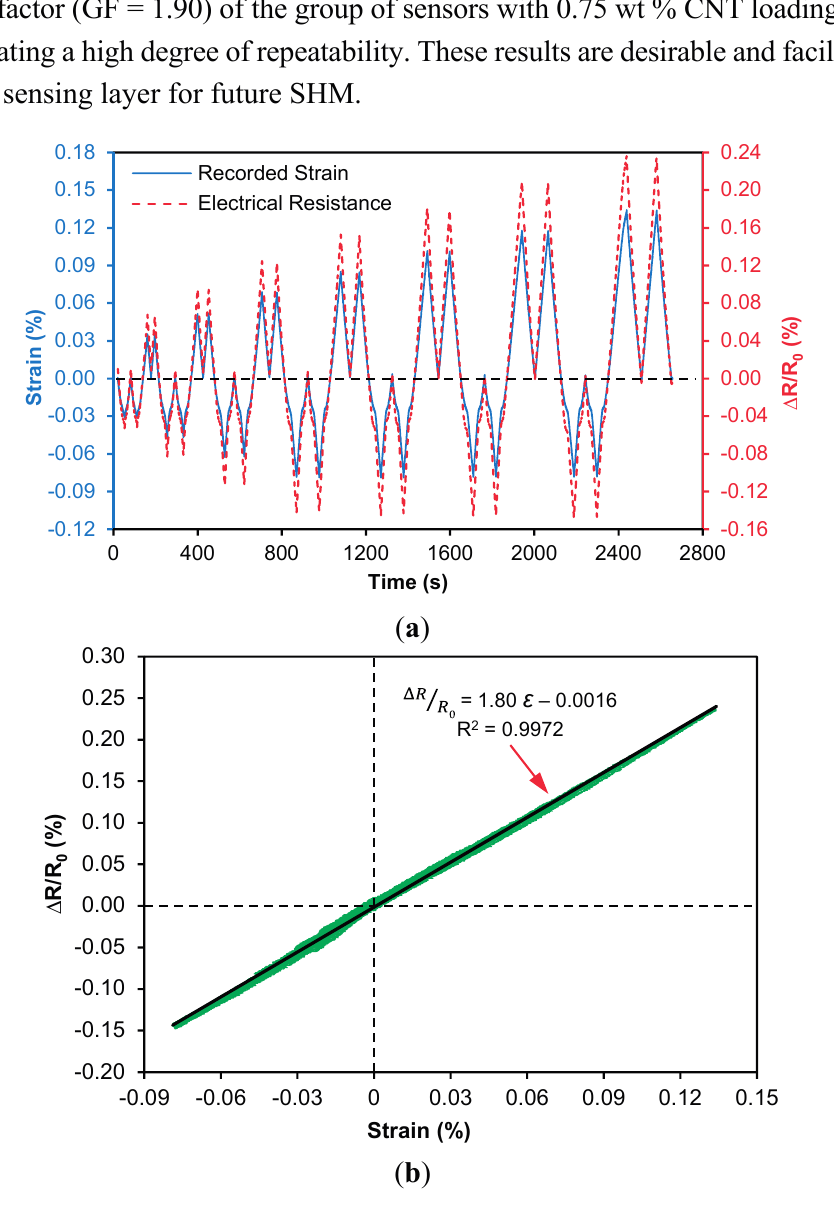
Figure 12. Linear-elastic piezoresistive response of CNT composite sensor on Specimen Al-0.75%-CNT according to applied compression-tension cyclic loads: ( a ) real-time response under cyclic loading and ( b ) linear piezoresistive behavior under tension-compression